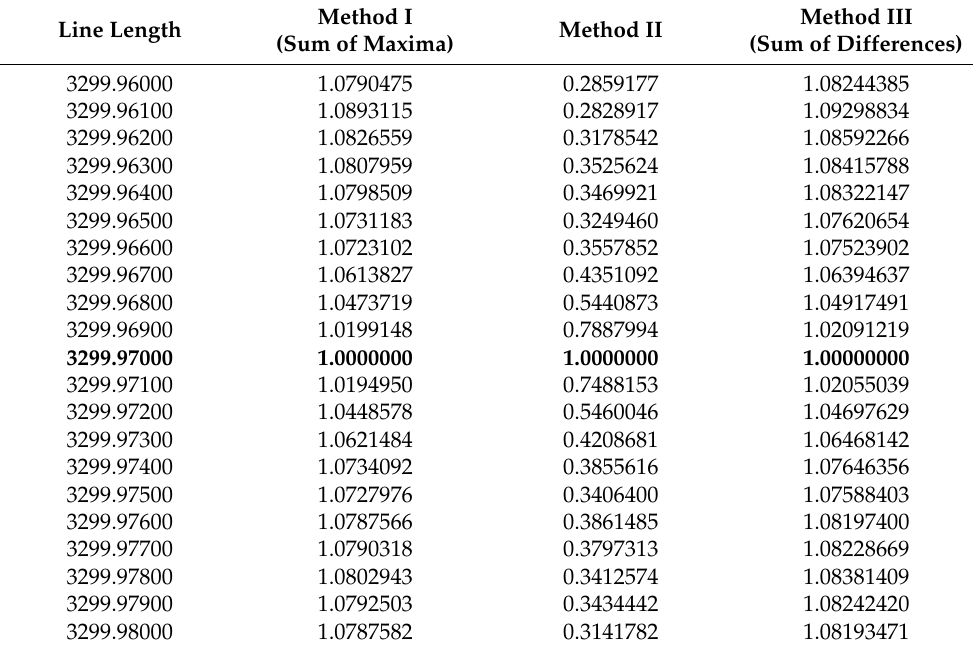
Table 15. Image line length estimation results for the accuracy ∆ = 0.001.